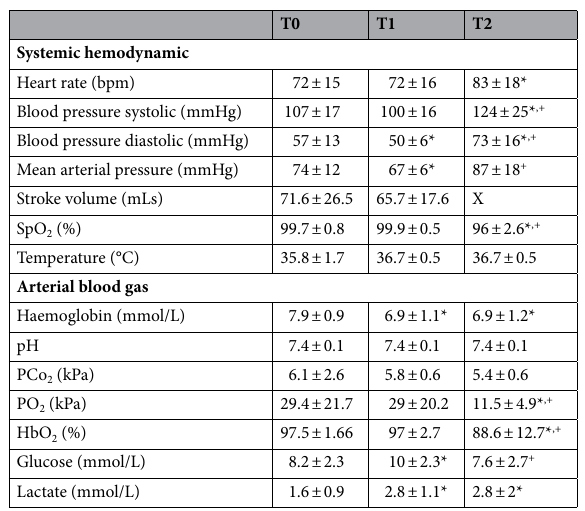
Table 2. Patient systemic hemodynamic and arterial blood gas results. T0 at the beginning of surgery, T1 at the end of surgery, T2 24 h after surgery. Values are represented as mean ± SD, * p < 0.05 compared to baseline T0, + p < 0.05 compared to T1.